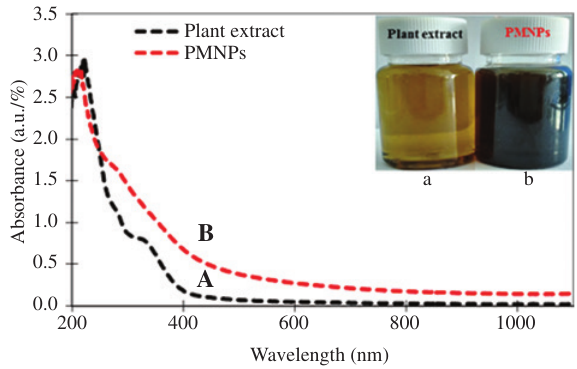
Figure 2: The UV-vis spectra of the (A) plant extract and (B) phy- togenic magnetic nanoparticles (PMNPs); inset shows the photo- graphic interpretation of the reaction (Reproduced from Ali et al. 2018 with permission from Royal Society of Chemistry, UK).